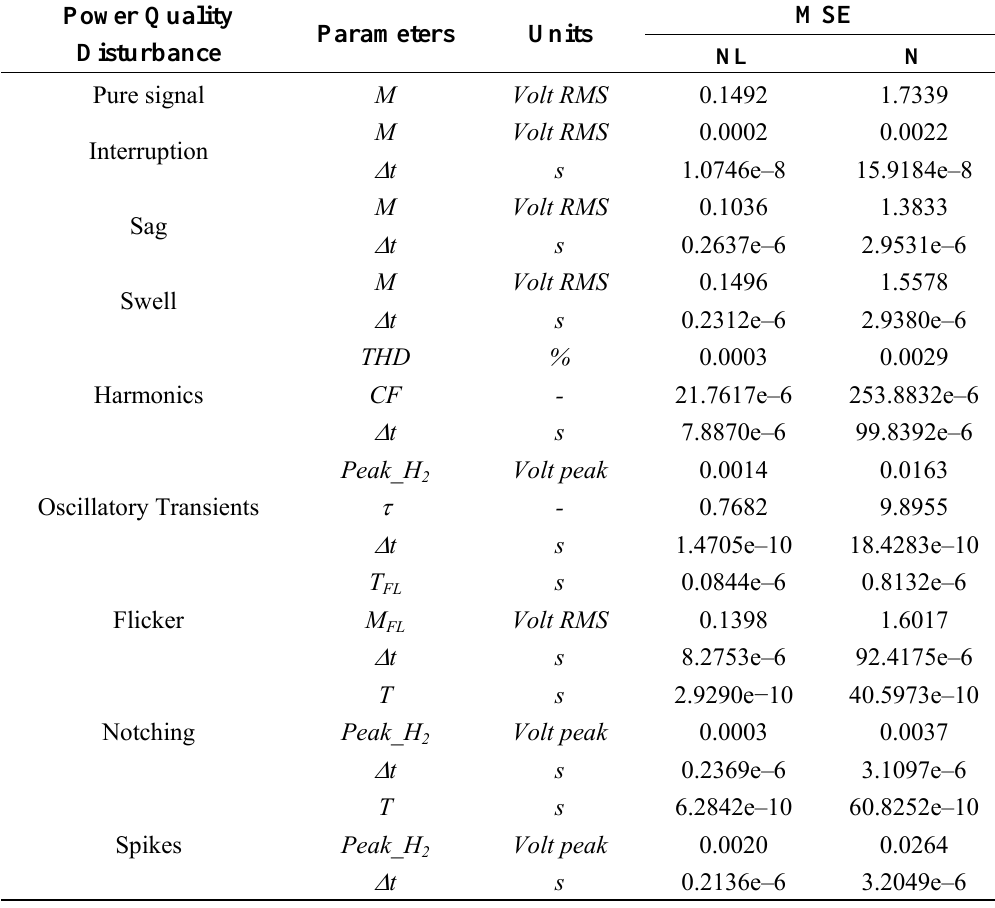
Table 5. MSE for quantification of PQD in noiseless (NL) and noisy (N) conditions. Power